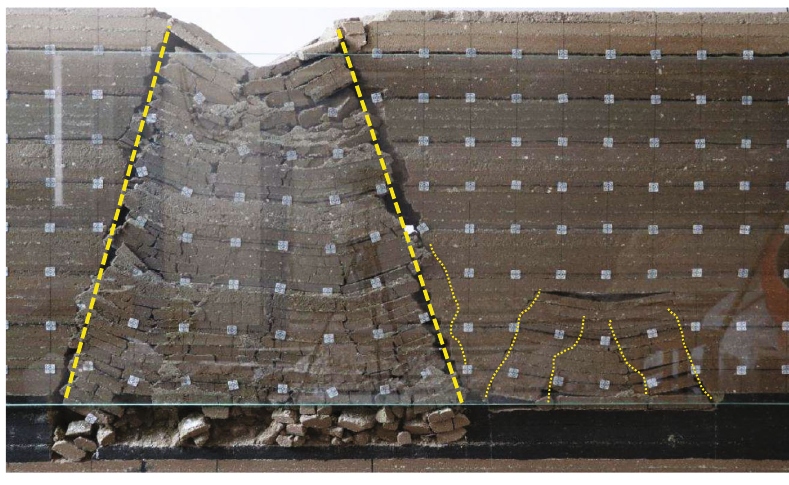
Figure 12: Fracture characteristics of overburden stratum in strati fi ed coal seam mining.